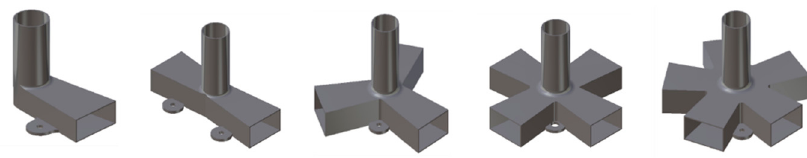
Figure 2. Models of the flow connector can have from two to six interfaces. One interface corresponds to a vertical circular inlet, and the other interfaces correspond to horizontal rectangular outlets.